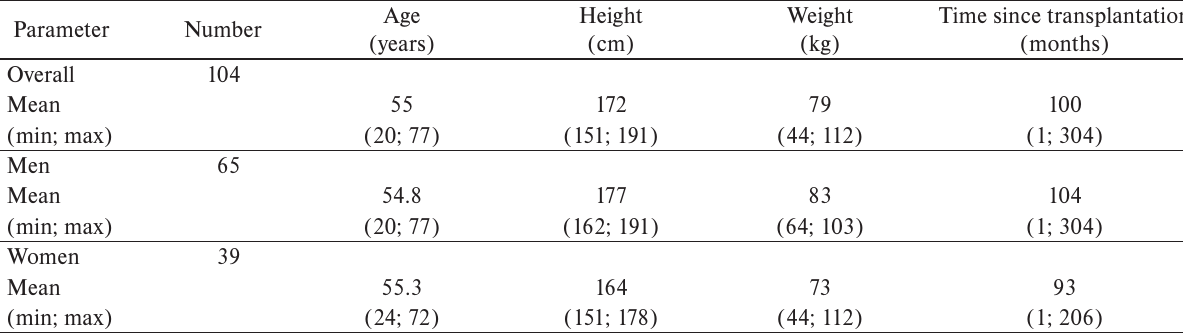
Table 1. principal demographic